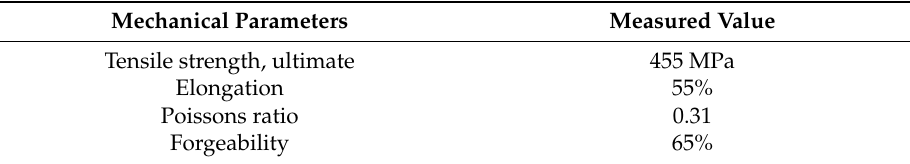
Table 3. The properties of natural diamond.